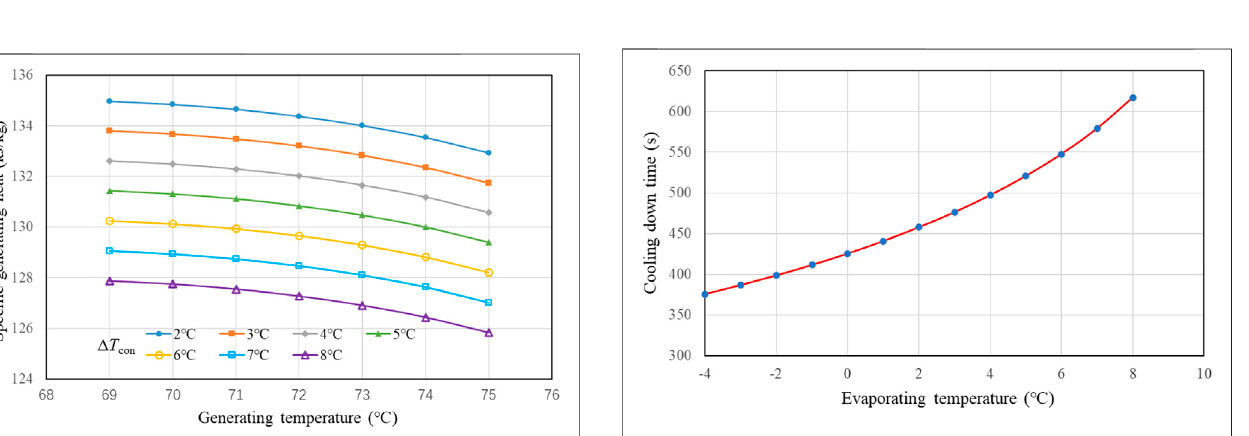
FIGURE 6 | Effects of generating temperature on pump electricity consumption.